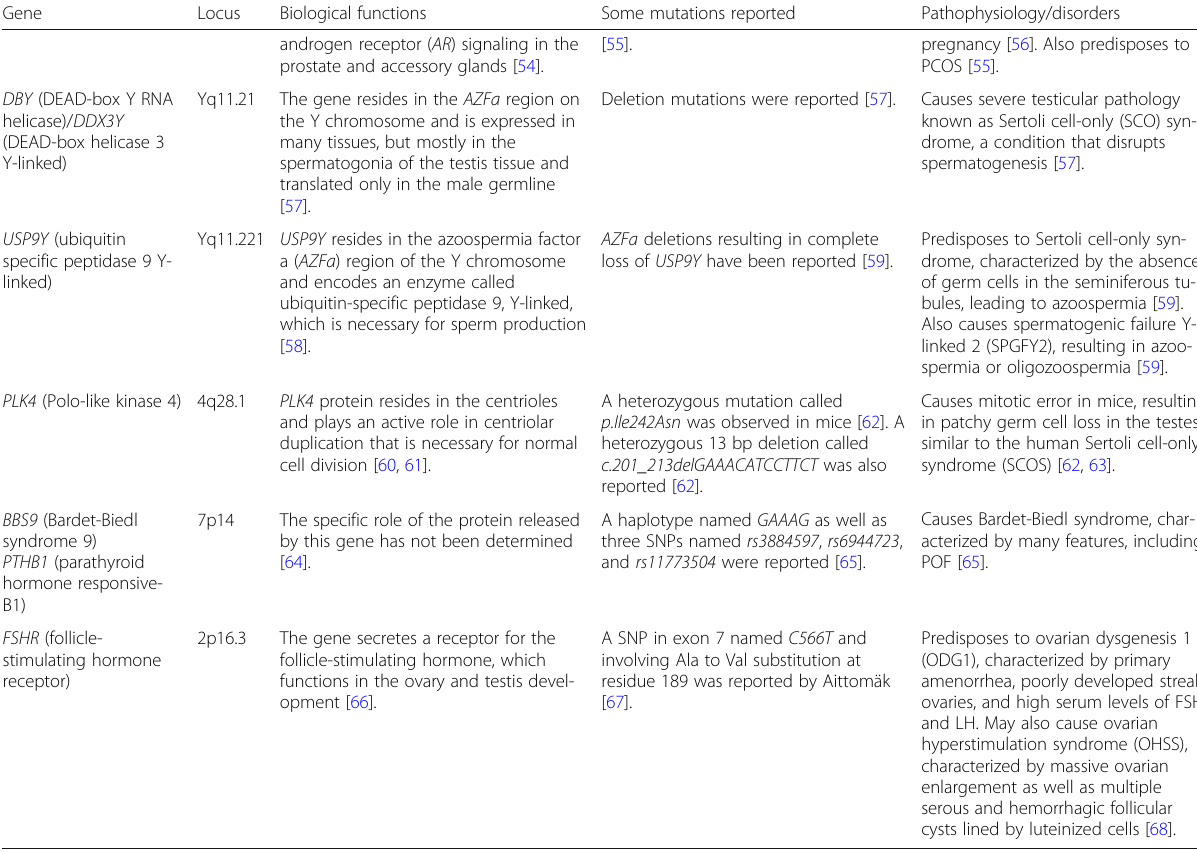
Table 1 Genes predisposing to syndromic infertility